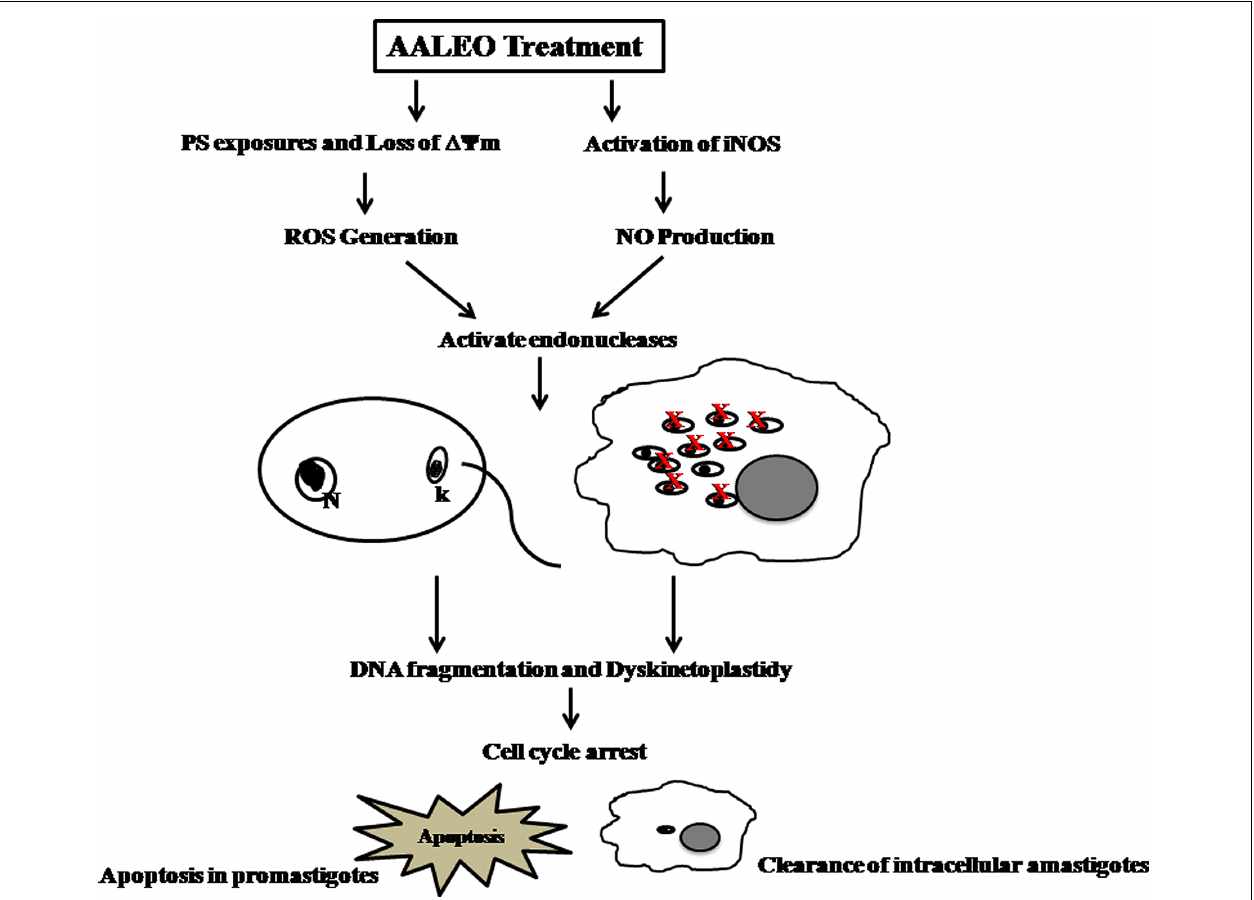
FIGURE 8 | Proposed model forAALEO-induced PCD in L. donovani promastigotes and amastigotes.